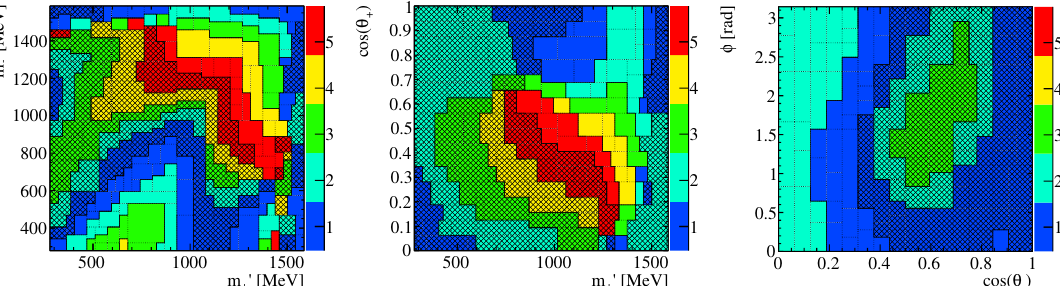
binning p = 1226 MeV, cos (cid:18) (cid:0) = 0 : 5 and (cid:0)